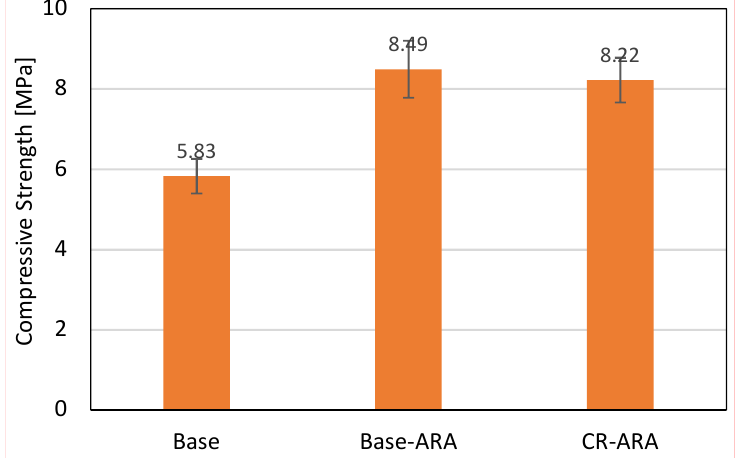
Figure 11. Compressive strength of asphalt mix at 15 °C.